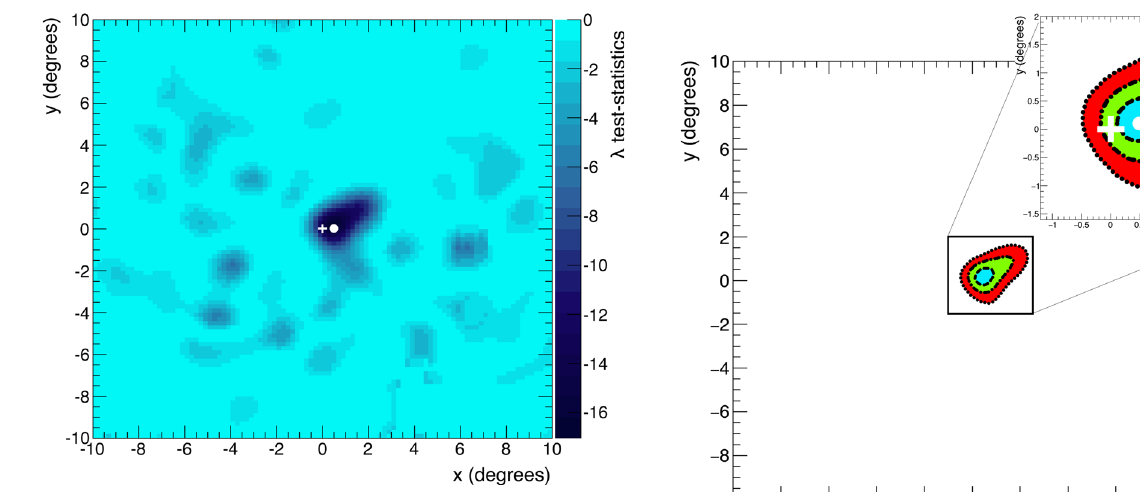
Fig. 5 Measured distribution of the test statistic λ from Eq. (3) in the fieldofviewaroundtheMoonnominalposition O ≡ ( 0 ◦ , 0 ◦ ) ,indicated by a white cross. The white dot refers to the coordinates ( 0 . 5 ◦ , 0 . 1 ◦ ) where the test statistics reaches the minimum ( λ min = − 17 . 05)